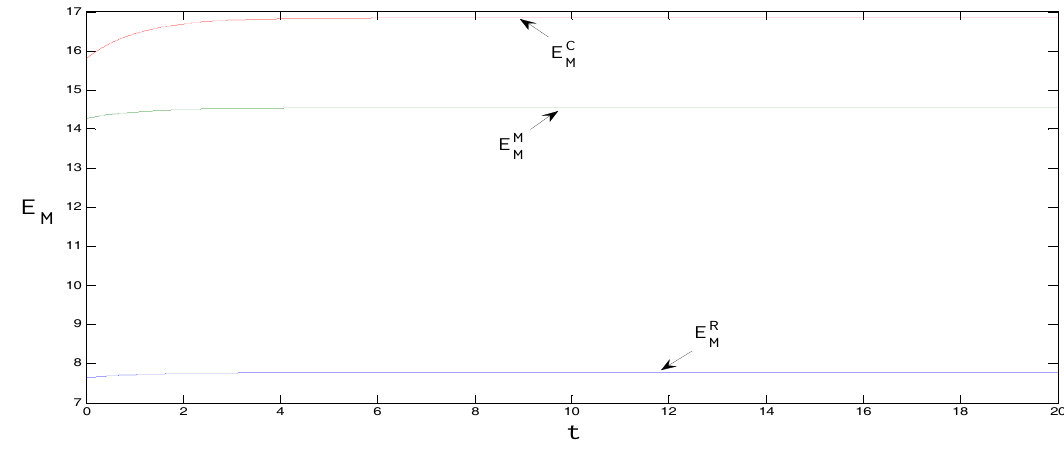
Figure 5. Comparison of emissions reduction efforts.